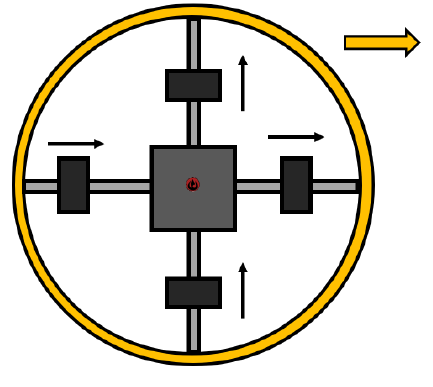
Figure 3. Principle sketch of a shifting masses